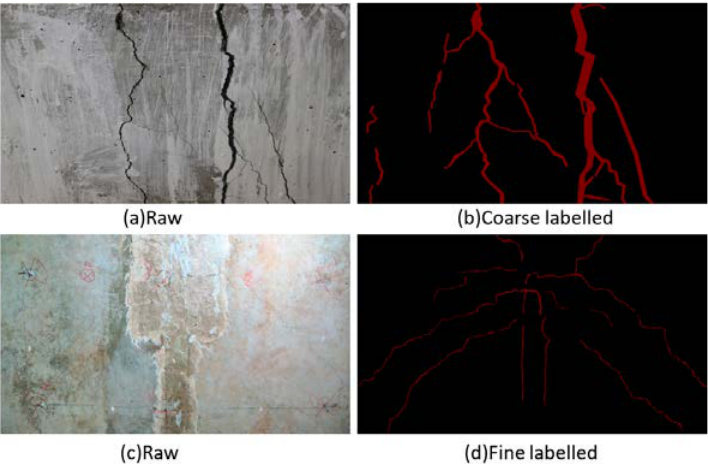
Figure 5. Comparison of CA and FA.